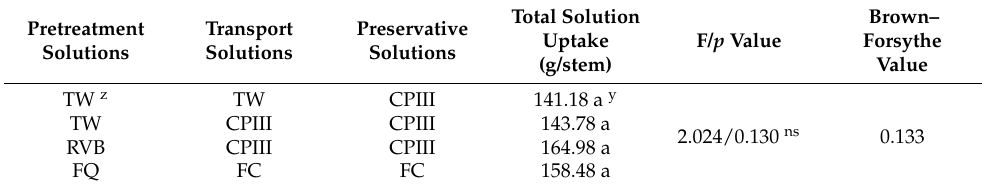
Table 3. Total solution uptake of cut hydrangea flowers ‘Verena’ by solution combination for each postharvest treatment stages in 2020.